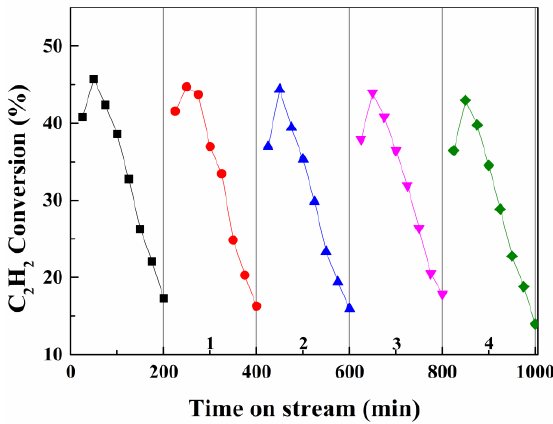
Figure 8. Durability and activity for acetylene hydrochlorination of the fresh and the regenerated IL/CaX catalysis, for 4 cycles. Reaction conditions: 320 °C, GHSV(C 2 H 2 ) = 300 h −1 ; V(HCl)/V(C 2 H 2 ) = 1.2.